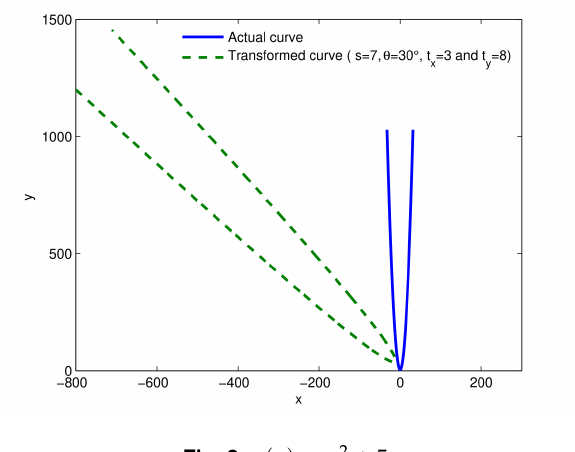
Fig. 2. g ( x ) = x 2 + 5.